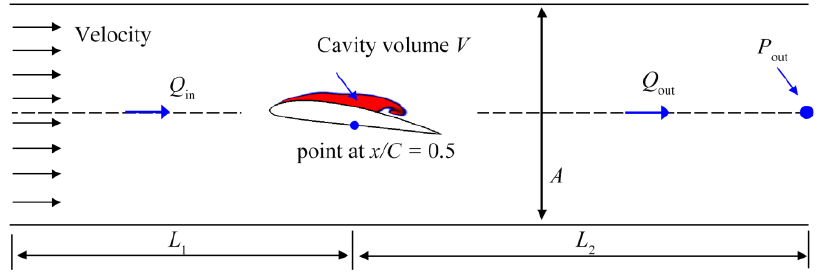
Figure 14. One-dimensional analytical model of pressure fluctuations induced by cavitation.